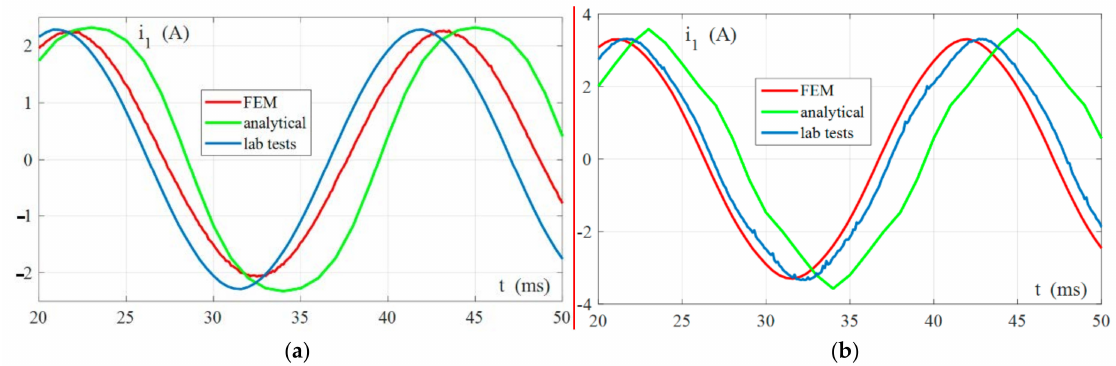
Figure 9. Waveform of current (phase 1): ( a ) AFPMG—coreless stator; ( b ) AFPMG—core stator.